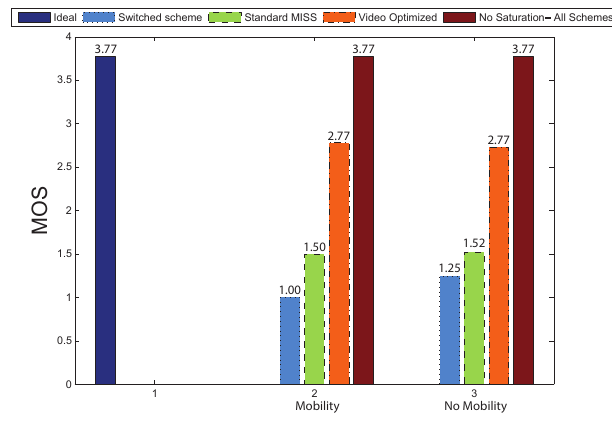
Figure 15. Summary of MOS Scores